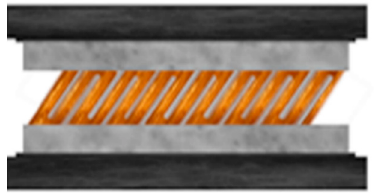
Figure 6. Low-temperature metallic gluing enabled by Ga- and In-coated nanorods